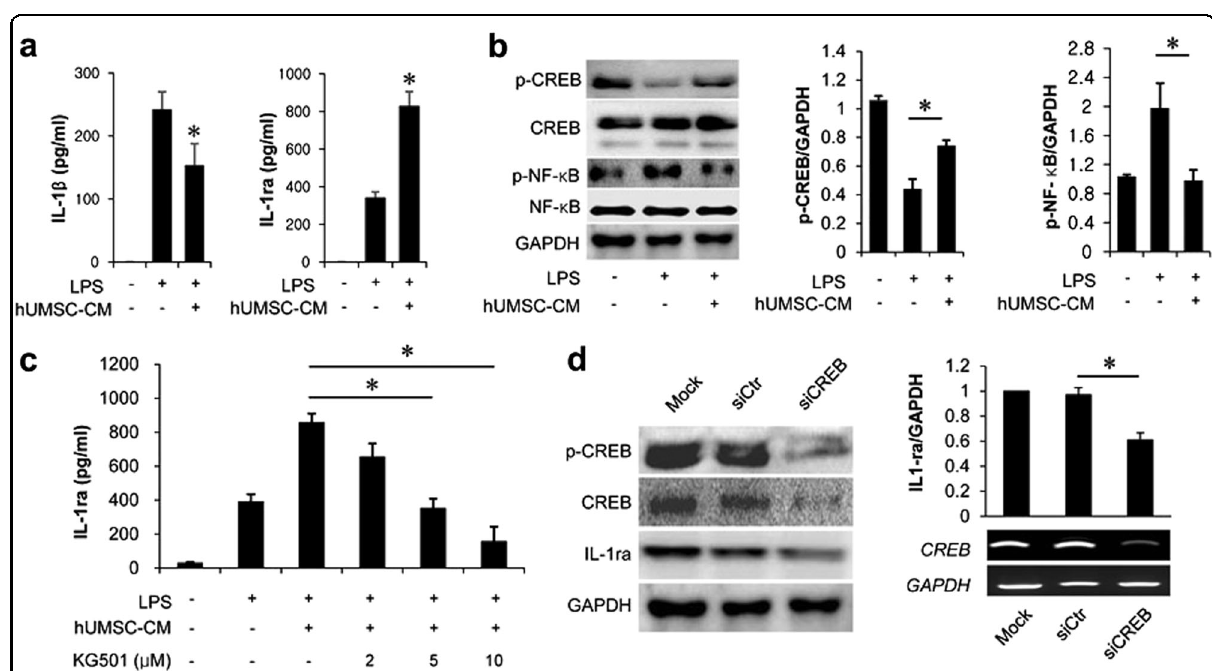
Fig. 5 In vitro expression of IL-1ra in LPS-stimulated macrophages after treatment with conditioned medium of hUMSCs. a IL-1 β and IL-1ra ELISA of raw 264.7 cells exposed to three treatment conditions (no LPS treatment, LPS treatment, LPS, and hUMSCs-CM treatment). b Western blot analysis of CREB, p-CREB, NF- κ B, and p-NF- κ B in lysates of raw 264.7 cells exposed to three treatment conditions (no LPS treatment, LPS treatment, LPS, and hUMSCs-CM treatment). c IL-1ra ELISA after treatment with KG501 (2, 5, and 10 μ M) in raw 264.7 cells exposed to three treatment conditions (no LPS treatment, LPS treatment, LPS, and hUMSCs-CM treatment). d Western blot analysis of IL-1ra after knockdown of CREB ( siCREB ) or control (siCtr) in raw 264.7 cells. The bands below the graph in the right panel show the gene expression of CREB and GAPDH by PCR. All data are presented as the mean ± SEM. * p < 0.05. LPS lipopolysaccharide, hUMSCs-CM conditioned medium of hUMSCs, siCREB siRNA for CREB , siCtr siRNA for